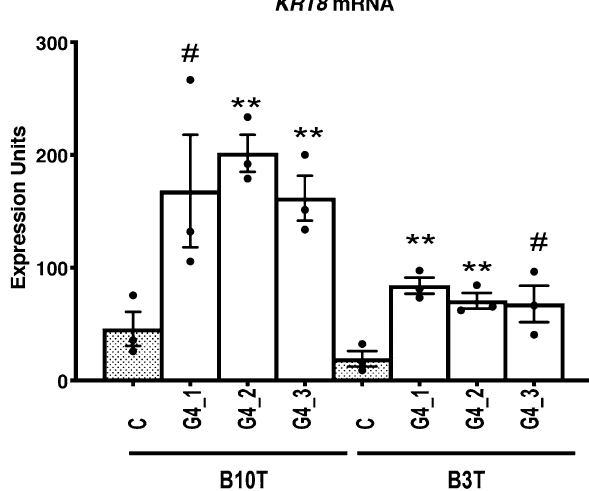
Figure 4. The columnar epithelial cell cytokeratin KRT8 was induced in human esophageal epithelial NES- B3T and NES-B10T cells expressing GATA4 protein. Expression of the steady-state level of KRT8 mRNA was examined by qRT-PCR in three pInducer20-GATA4 cell clones (G4_1, G4_2, G4_3) and one pInducer20 control cell clone (C) per cell line after 72 h of doxycycline treatment to induce GATA4. qRT-PCR demonstrated up-regulation of KRT8 mRNA in NES-B3T and NES-B10T cells expressing GATA4 compared with controls cells lacking GATA4 protein (n = 3 experiments; **P ≤ 0.01; # P = 0.0788, NES-B10T clone G4_1 and P = 0.0503, NES- B3T clone